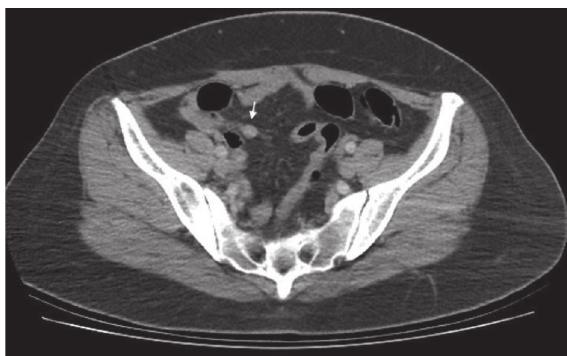
Figure 1: Suspicious mass appearance in the distal of the appendix (white arrow).